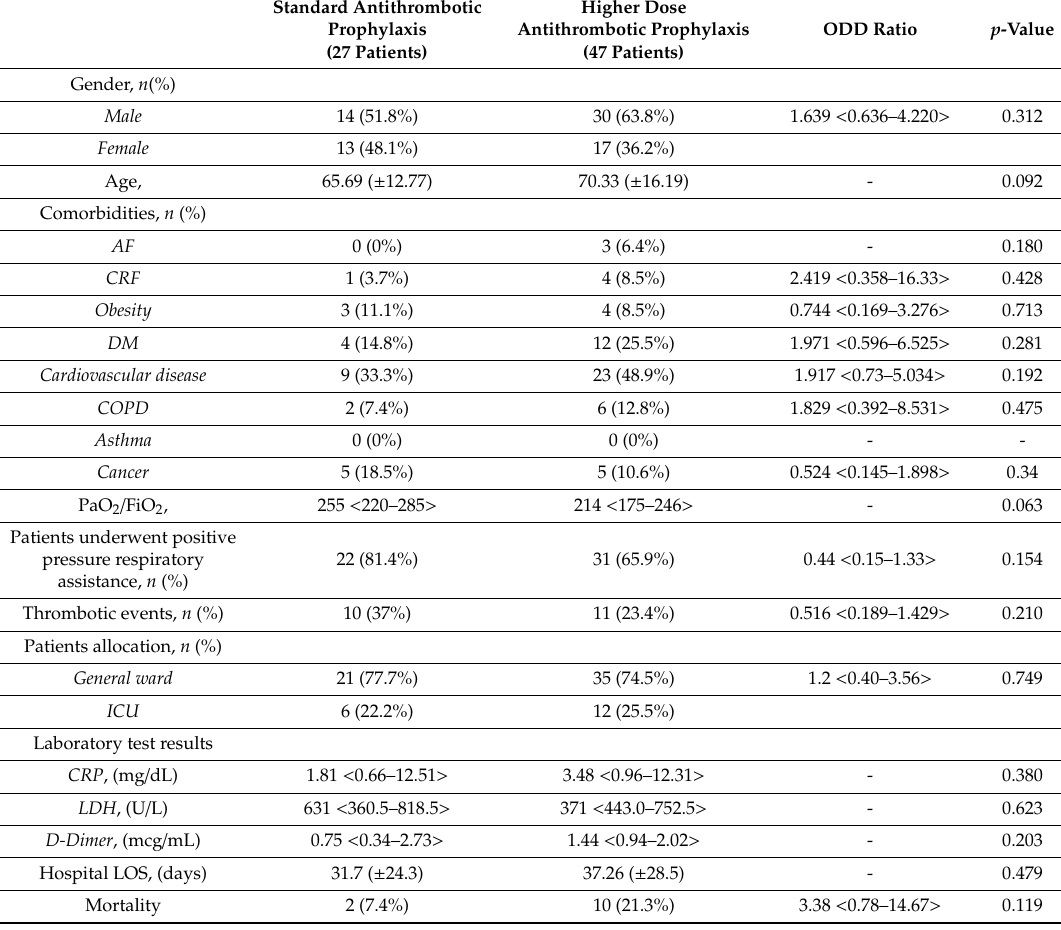
Figure 1. Antithrombotic prophylaxis: molecules and doses. Table 4. Association analysis between venous thrombosis prophylaxis and principal demographic, clinical characteristics and comorbidities. Parametric data were represented as mean (standard deviation) and non-parametric data as median < 1st, 3rd interquartile >